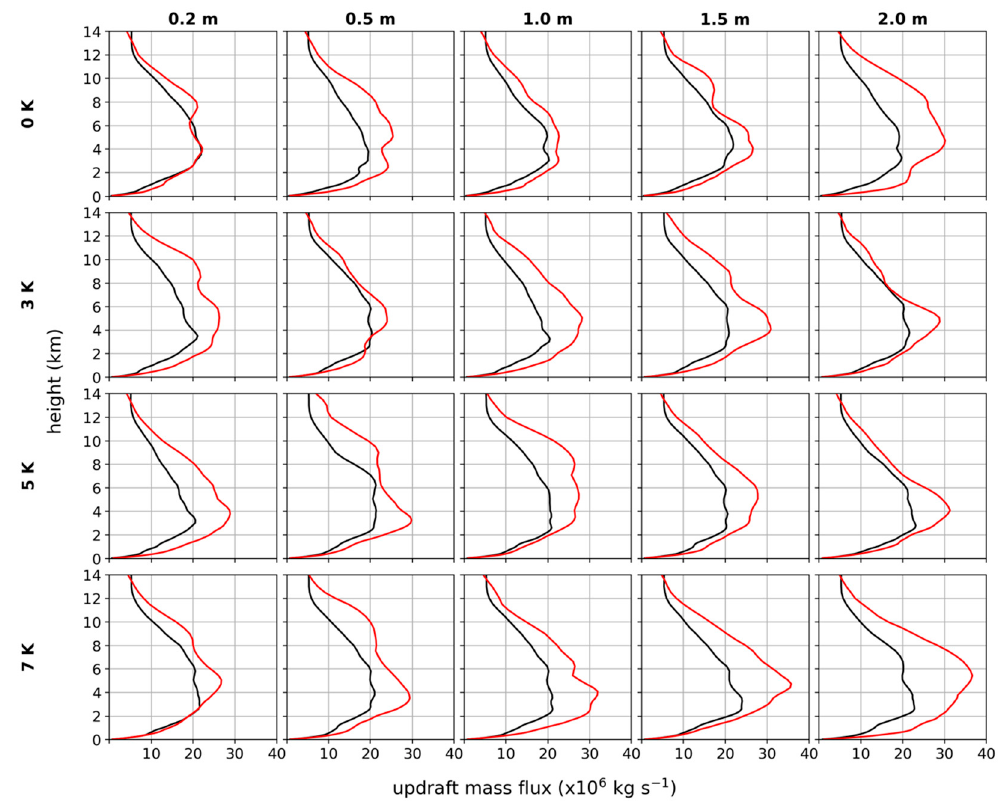
Figure 15. Updraft mass flux at t = 120 min (black line) and t = 165 min (red line).